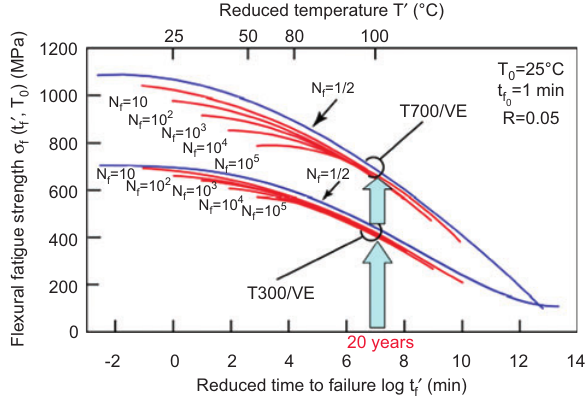
) of Hexcel 8552 resin system with Weibull parameters (data generated by Miyano). m